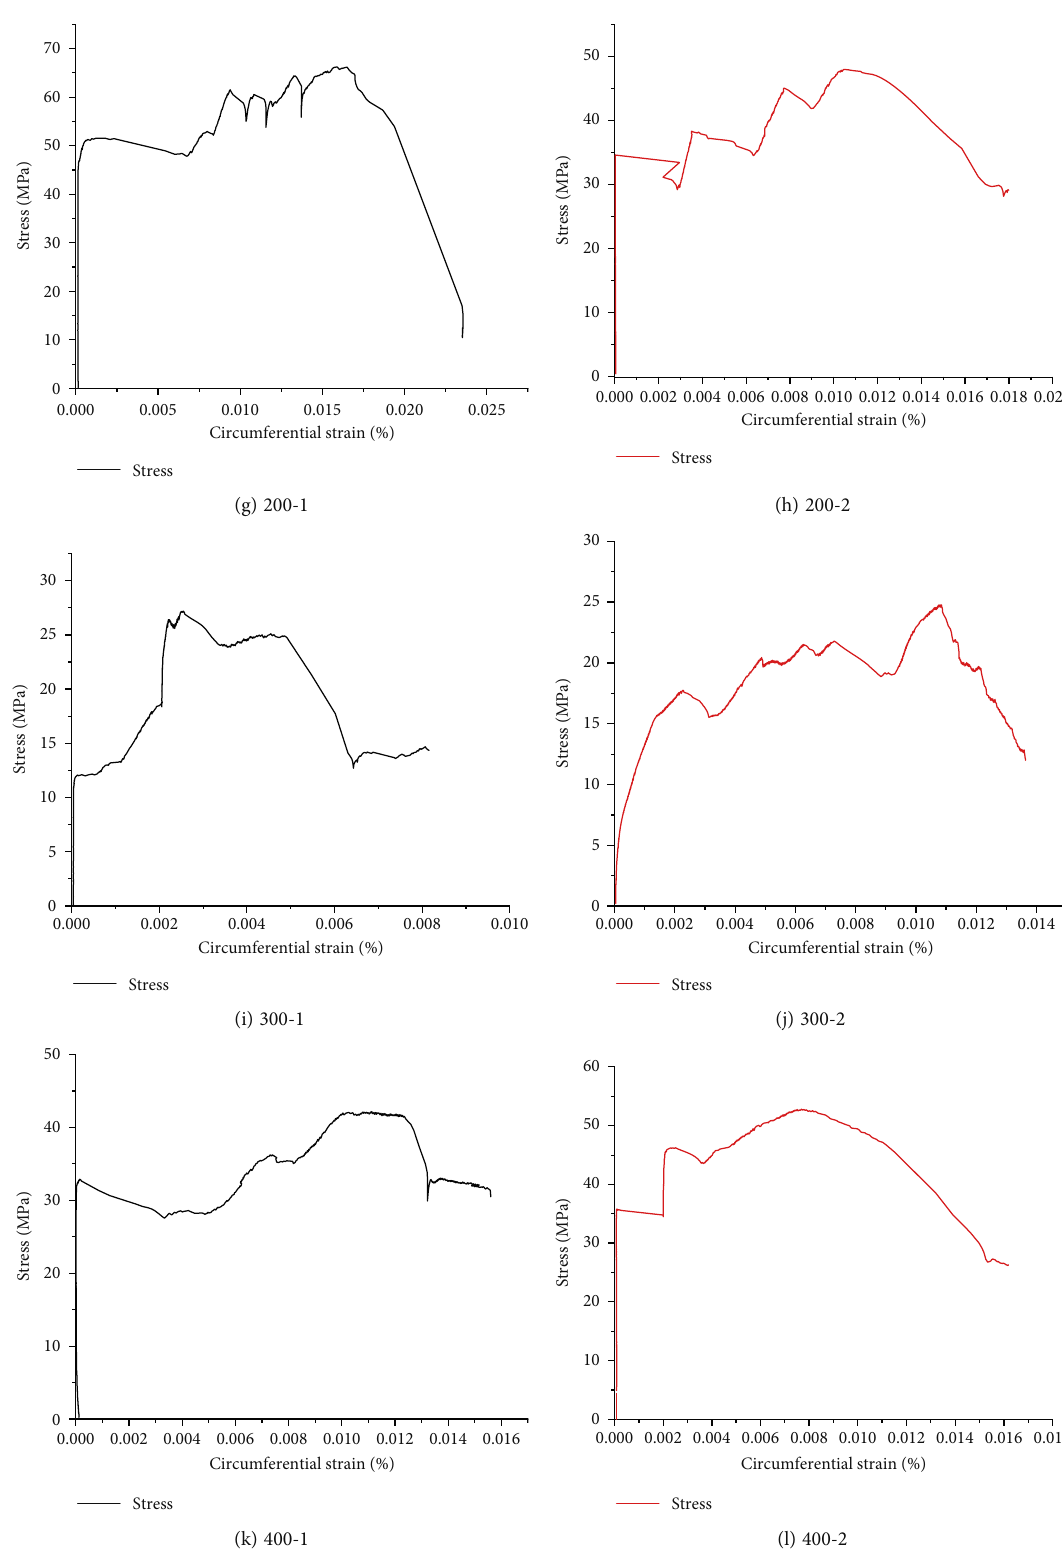
Figure 2: The connection between axial stress and circumferential strain of rock